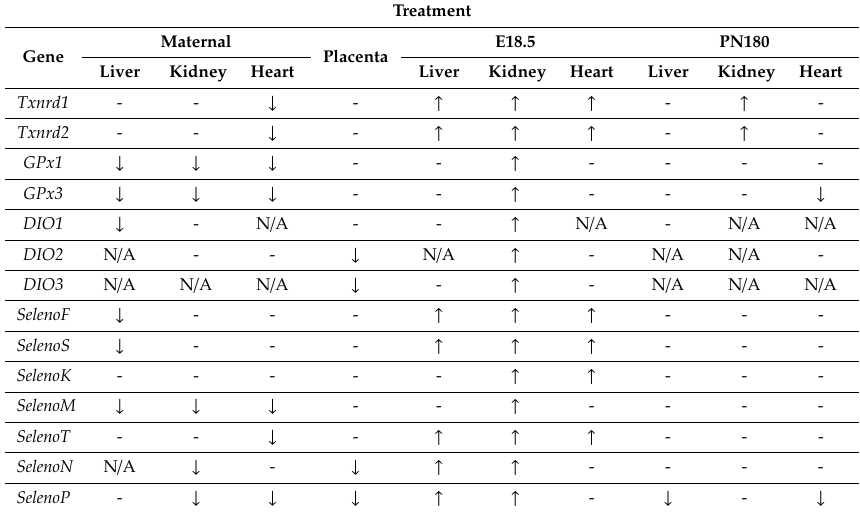
Table 1. Summary table of the e ff ects of selenium deficiency on selenoprotein expression in various maternal and o ff spring tissues.